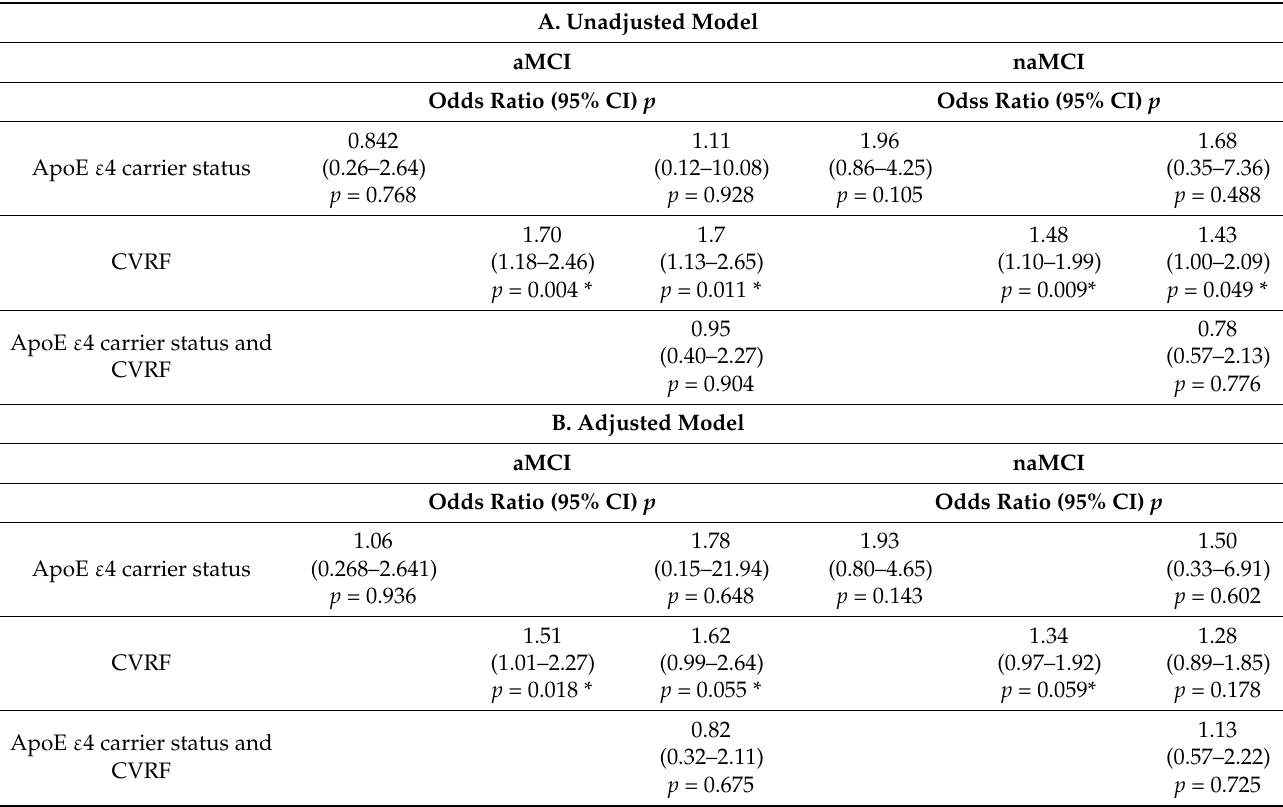
Table 3. Multiple Regression effect of the ApoE ε 4carrier status on the NC, amnestic and non-amnestic MCI